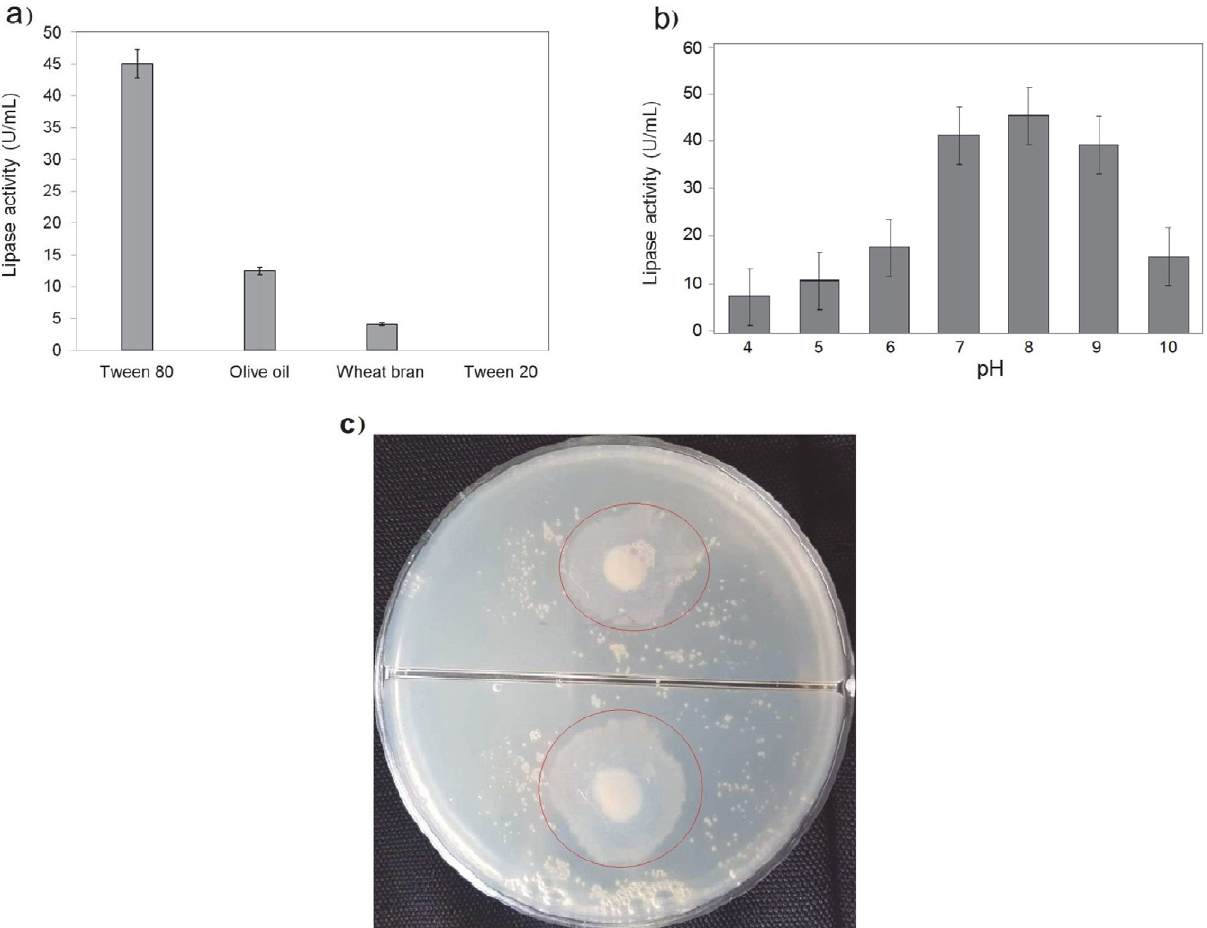
Figure 1 . Influence of various carbon sources on the AKL29 activity (a). Effect of pH on the AKL29 activity (b). The lipase activities were measured at 35 °C, pH 8, after three days using different carbon sources, and different pH. The experiments were conducted three times and the error bars represent standard deviation. Hydrolysis zone formed by the lipolytic strain Cpt29